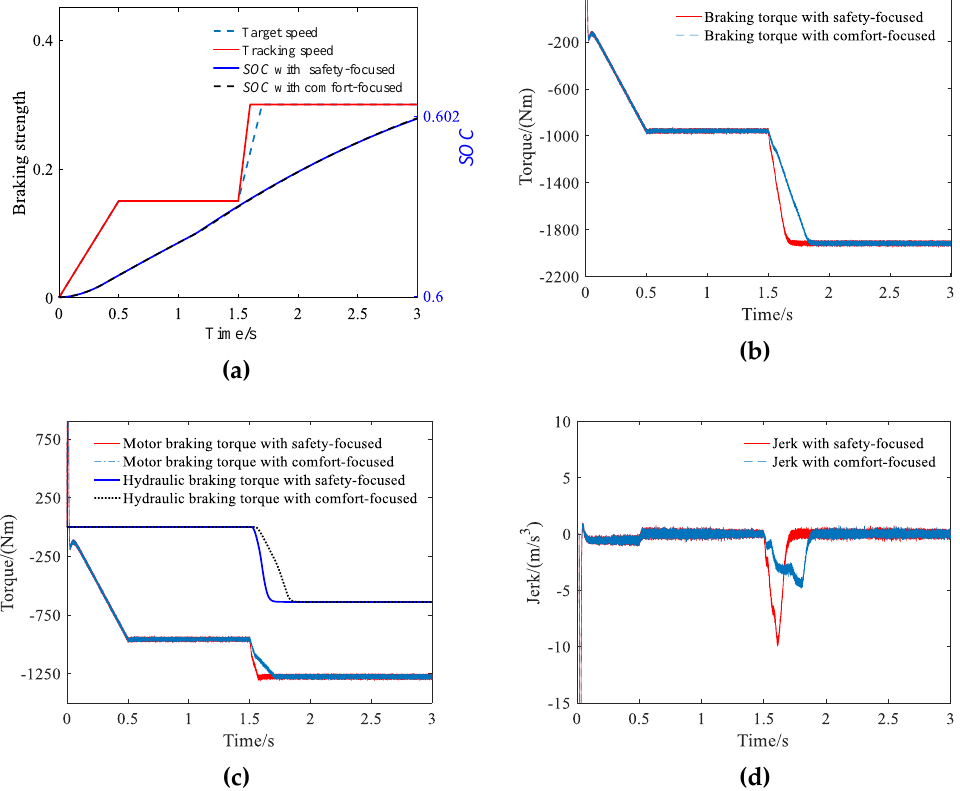
Figure 15. Simulation results of the pure motor switch to a hybrid braking mode under variable braking strengths: ( a ) The variation in the braking strength and SOC , ( b ) the variation in total braking torque, ( c ) the variation in motor and hydraulic braking torque, and ( d ) the variation in vehicle jerk.